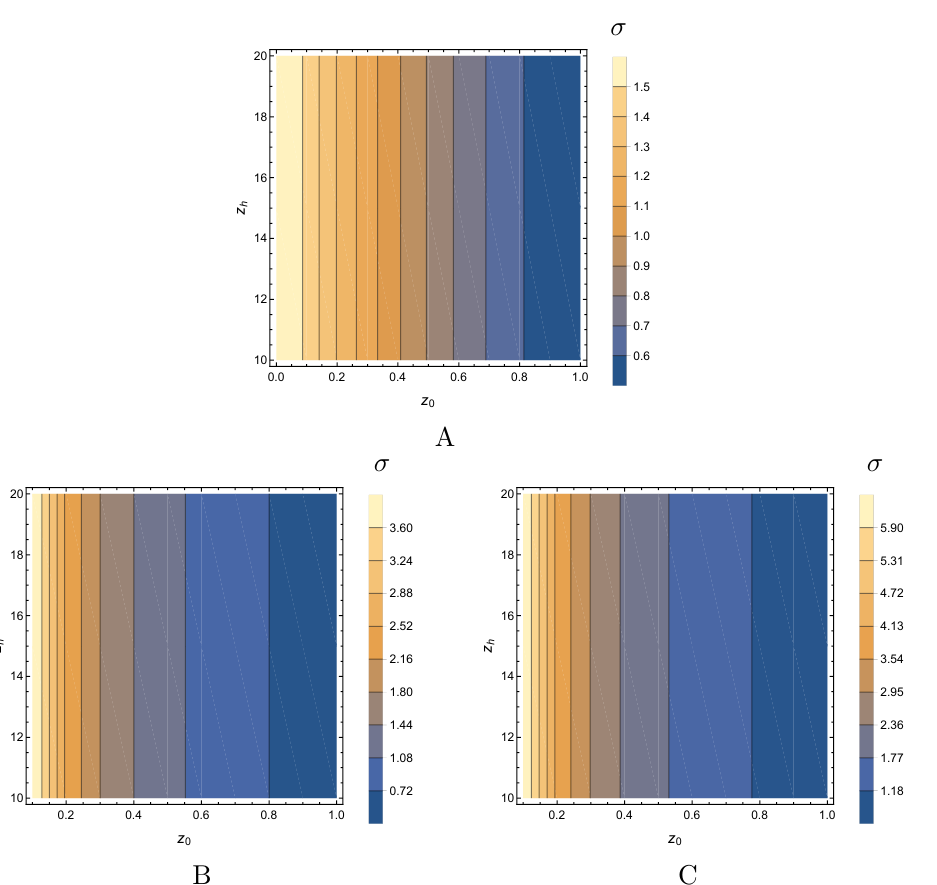
Figure 15 . Contour plot of the string tension as function of z 0 and z h for µ = 0 , ν = 1 (A), and for µ = 0 . 2 , ν = 4 . 5 , longitudinal (B) and transversal (C); a = 4 . 046 , b = 0 . 01613 , c = 0 . 227 . tension for fixed z depends on z weakly in all cases (figure 18). Due to the 0 h